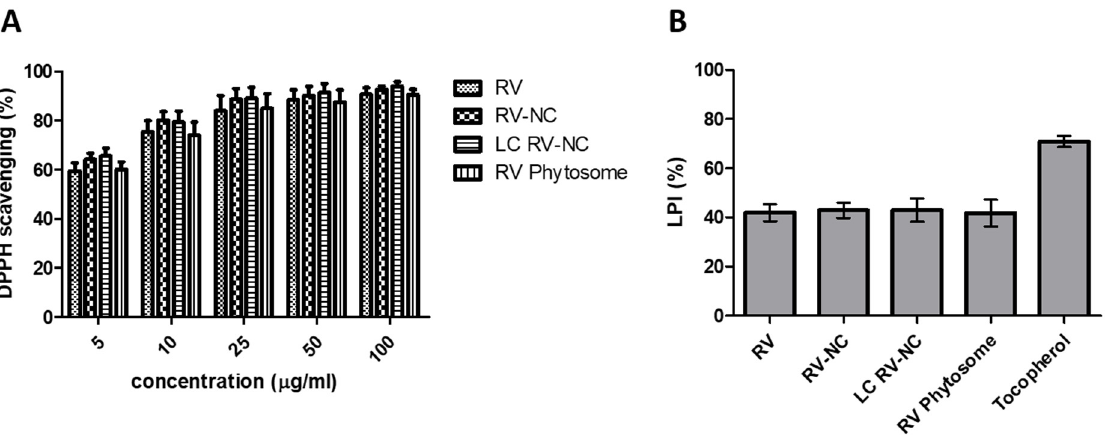
Figure 5. ( A ) In vitro antioxidant activity of trans -resveratrol nanocrystals (RV-NC), lipid-coated trans -resveratrol nanocrystals (LC RV-NC), RV Phytosome ® and the coarse RV suspension (RV) at different concentrations, expressed as DPPH radical scavenging percentage. ( B ) Lipid peroxidation inhibition activity of trans -resveratrol nanocrystals (RV-NC), lipid coated trans -resveratrol nanocrystals (LC RV-NC), RV Phytosome ® and the coarse RV suspension (RV), evaluated in a TBA assay. The experiments were conducted in triplicate and data are presented as means ± standard deviation (SD).